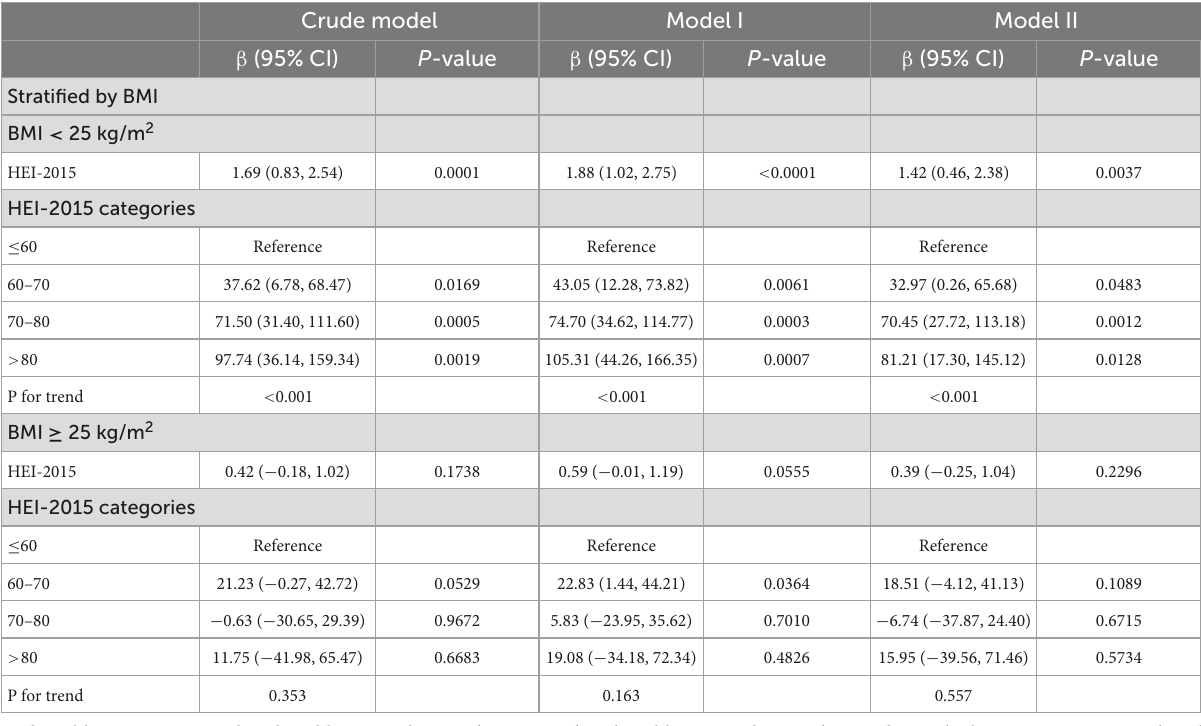
TABLE 5 Relationship between Healthy Eating Index (HEI)-2015 and S-Klotho stratified by BMI. Crude model Model